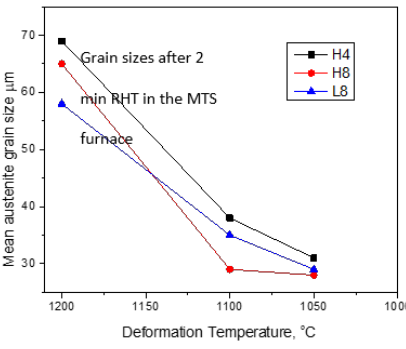
Figure 14. Mean austenite grain size after two passes with 15% reduction / pass at the respective deformation temperature; each sample was quenched, and prior austenite grain size was analyzed.